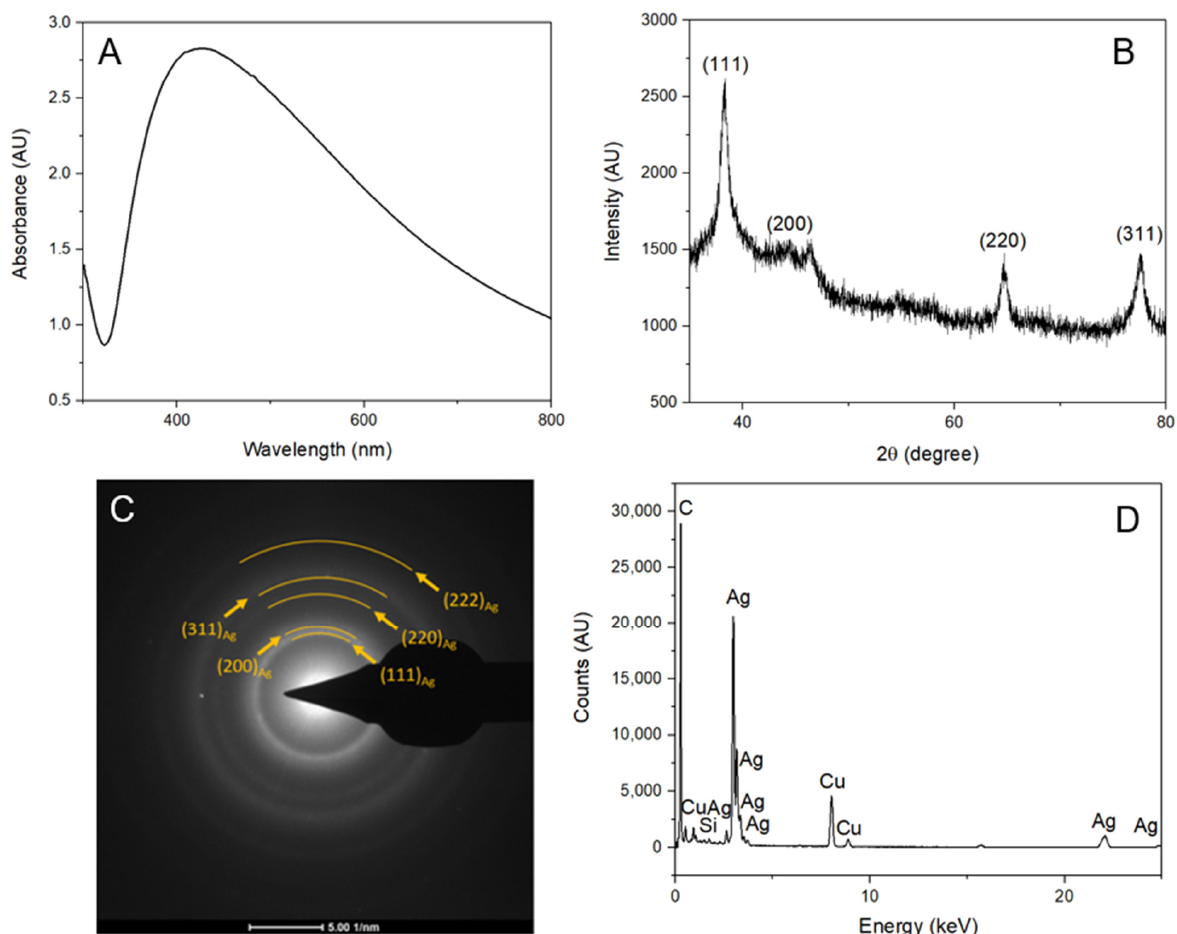
Figure 5. Characterization of the AgNPs synthesized with a mixture of lemon, orange, and grapefruit peels extract. ( A ) UV-vis absorbance spectrum of the AgNPs. ( B ) XRD pattern of the AgNPs with labeled diffraction peaks. ( C ) SAED pattern of the AgNPs with the rings labeled. ( D ). EDS spectrum of the AgNPs with the peaks labeled.